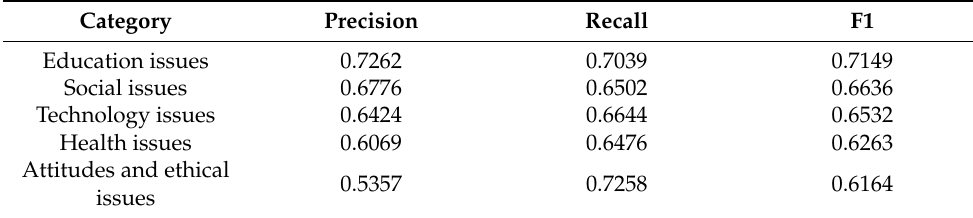
Table 6. Evaluation measures with SVM for each category.